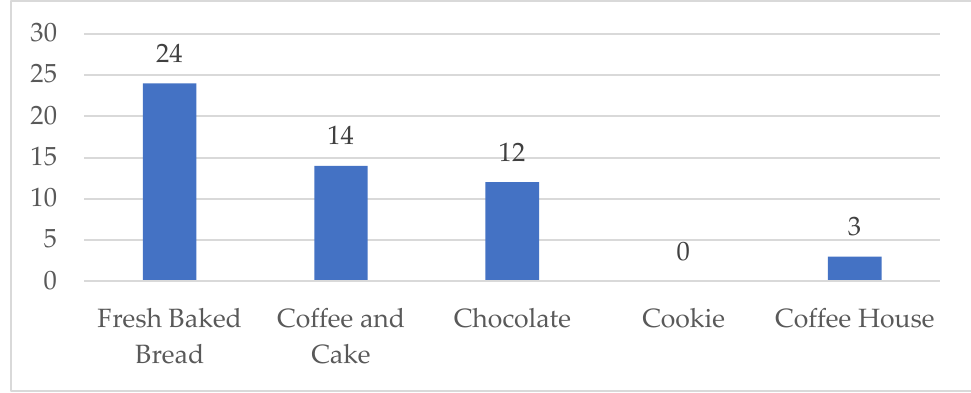
Figure 8. Explicit aroma selection for the department of pastry and bakery products.